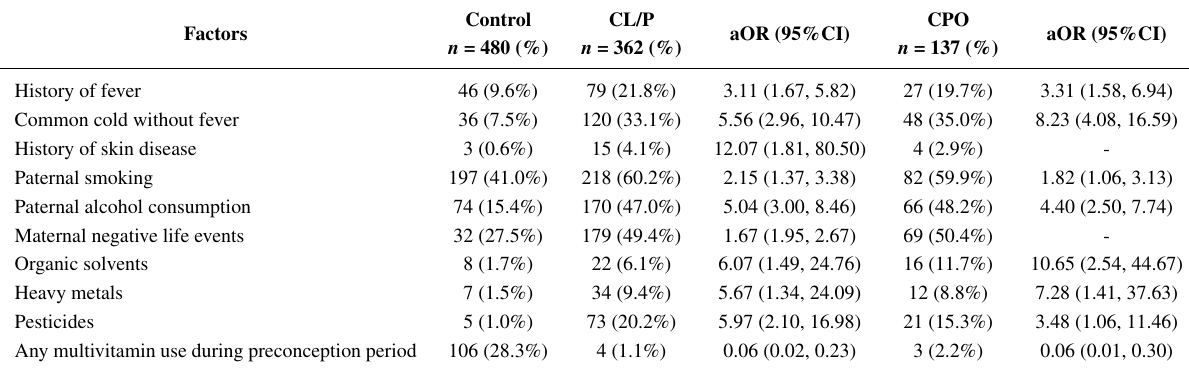
Table 4. Multivariable logistic regression of case and control